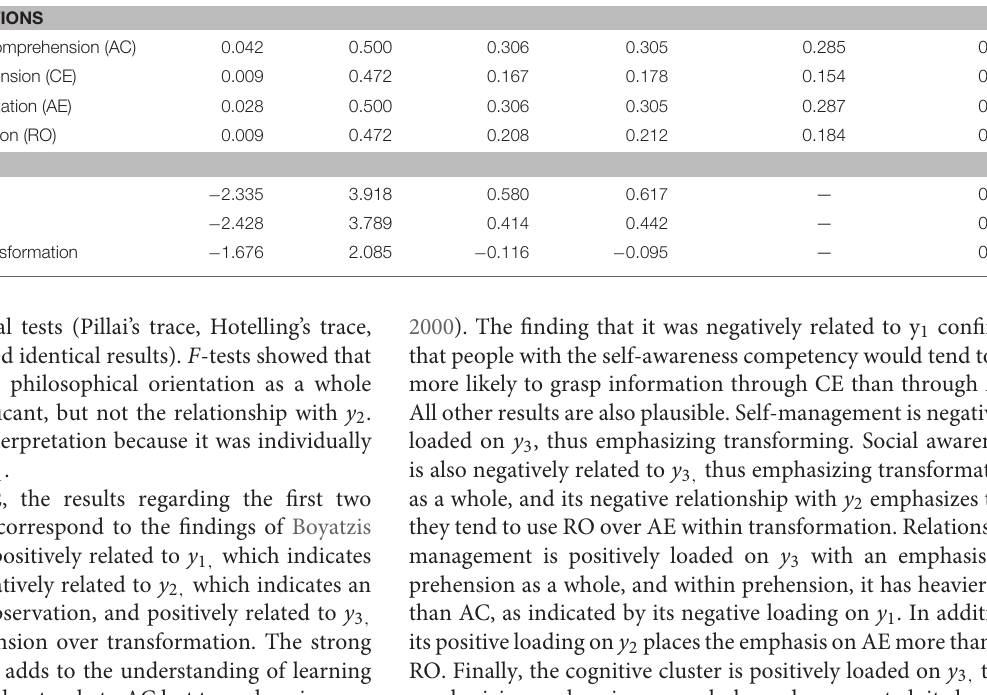
TABLE 1 | Description of mode components ( x d ) and log ratios ( y d ).